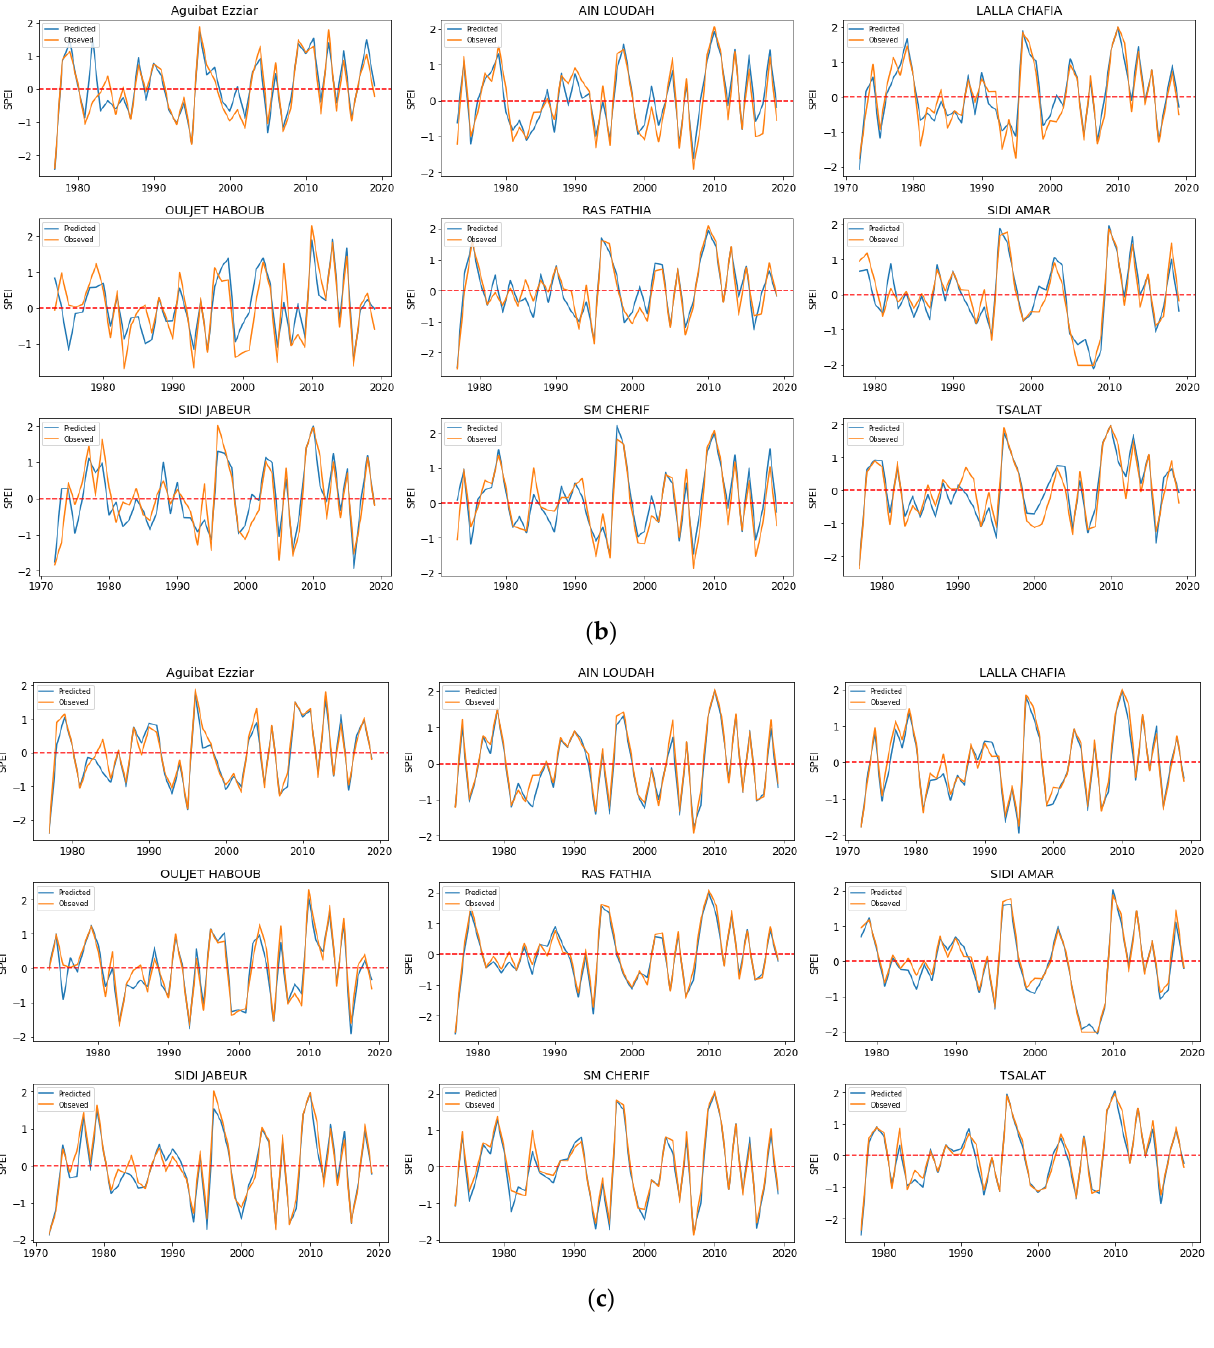
Figure 9. Examples of superposed plots comparing calculated and predicted annual SPEI. SPEI prediction of August from September ( a ), from December ( b ), and from April ( c ).